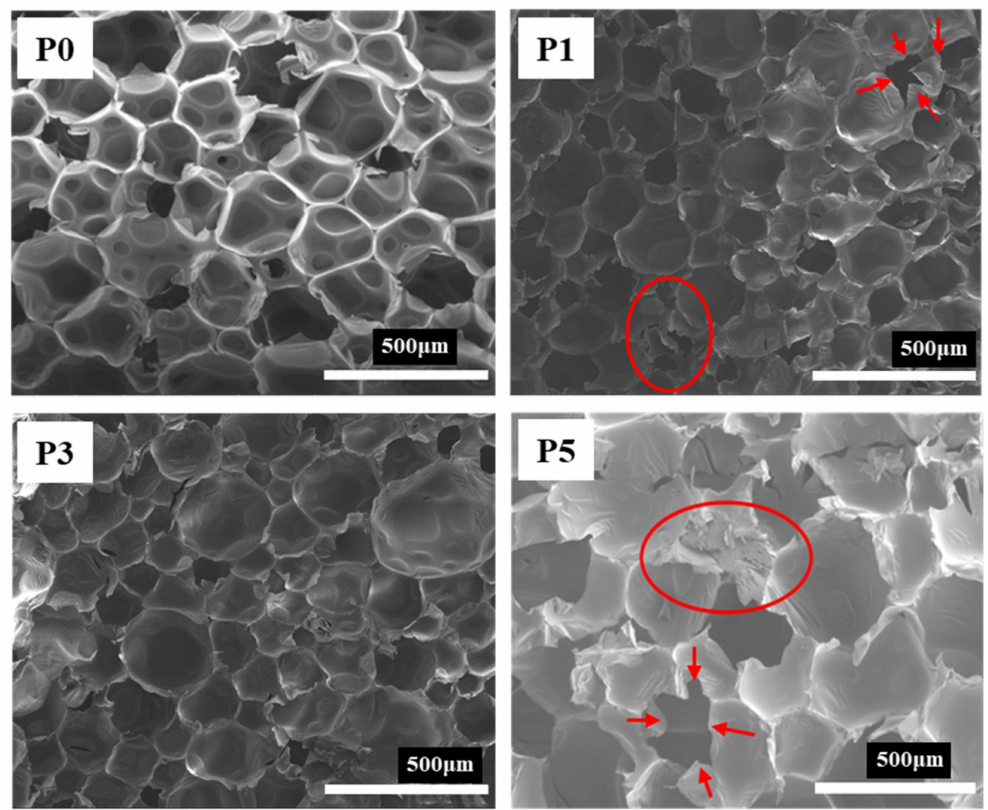
Figure 4. SEM morphology of RPUF with di ff erent